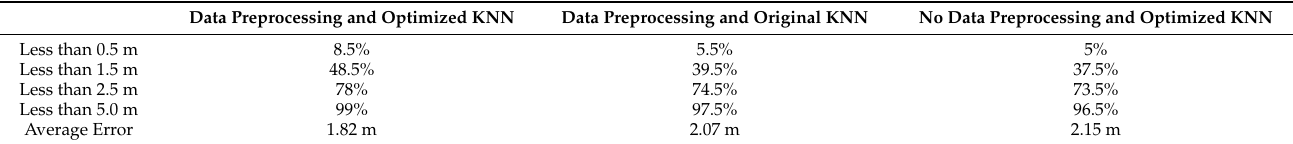
Figure 9. Errors when people stay still (static), and when people move (dynamic). 4.3. The Possibility of Promotion Nowadays, different countries have adopted different COVID-19 control policies. Many countries (e.g., Australia) have abandoned zero-COVID policies. It does not mean they have given up on COVID-19 control. Some other measures, such as large-scale